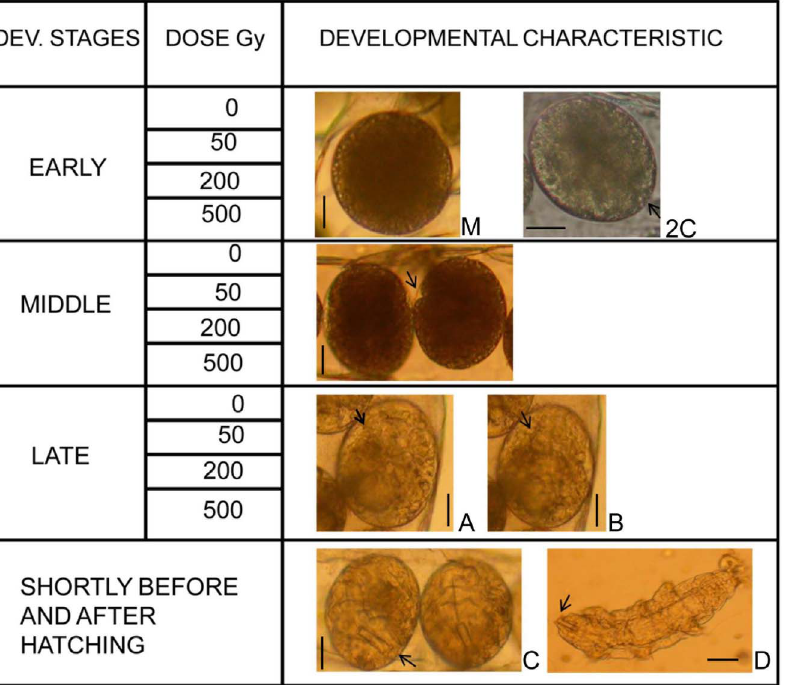
Figure 1. Experimental design with developmental stages, gamma radiation dose levels, and light microscopy photos showing characteristics of embryos in the different developmental stages. The figure shows pictures of non-irradiated embryos representative of the developmental stages used in the experiment. Early stage: Morula (M) and 2-cell stage (2C) of different eggs (arrow indicates the division between the two cells). Middle stage: Formation of the ventro-transversal cleft, indicated by an arrow. Late stage: The rotatory movement caused a slight change in the position of the embryo in the egg. The two pictures are from the same egg with the embryo in different positions, indicated by a structural change from picture A to B in the area pointed at by the arrows. Shortly before and after hatching: Before hatching it is possible to see the buccal tube, indicated by an arrow, which is also visible in the new born larvae. Scale bars in all pictures represent 25 m m.